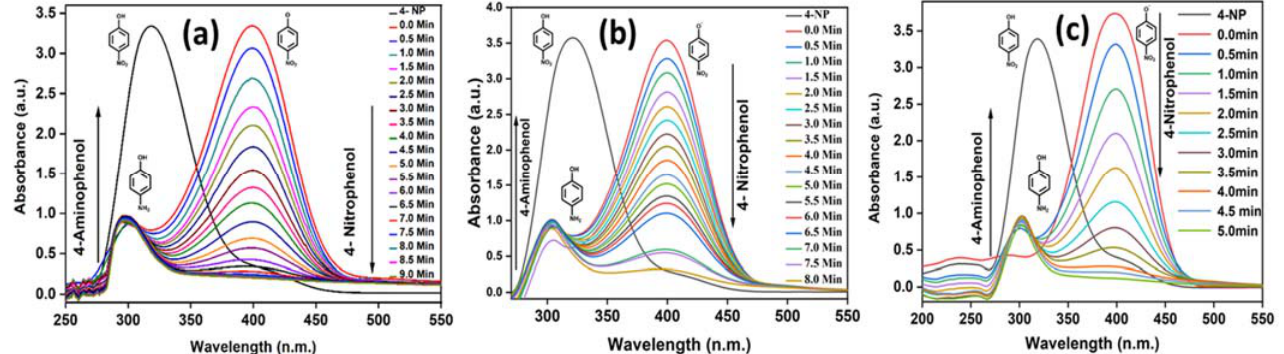
Figure 7. UV ‐ Vis spectra of the catalytic reduction of 4 ‐ NP to 4 ‐ AP at different reaction times and different concentrations of UiO ‐ 66: ( a ) 0.2 mg, ( b ) 0.3 mg, and ( c ) 0.5 mg. The absorbance peak at 300, 317, and 400 nm corresponds to 4 ‐ AP, Phenolate ion, and 4 ‐ NP, respectively. On addition of UiO ‐ 66 nano particles, the intensity of the absorption peak at 400 nm started decreasing, whereas the peak at 300 nm started increasing, indicating the progress of the catalytic reduction.